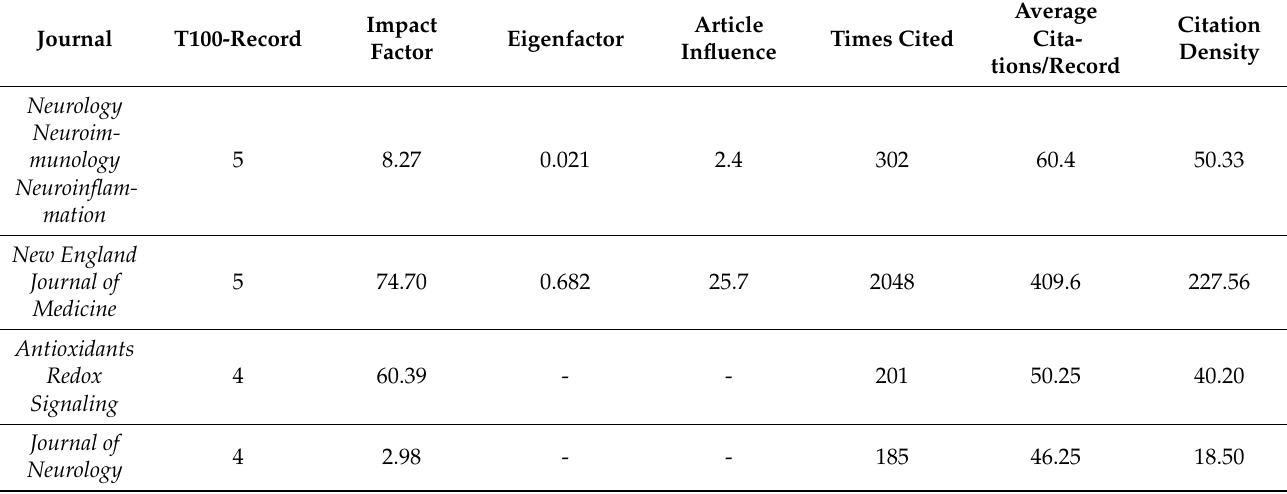
Table 5. Journals publishing more than 4 of the top 100 (T100) papers are arranged by the number of T100